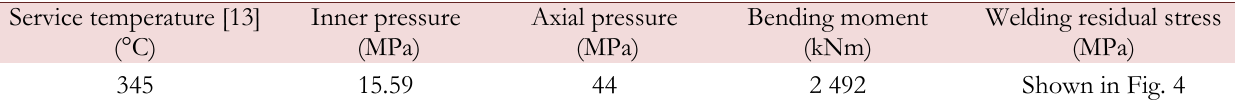
Table 2: Normal operating loads for RPV